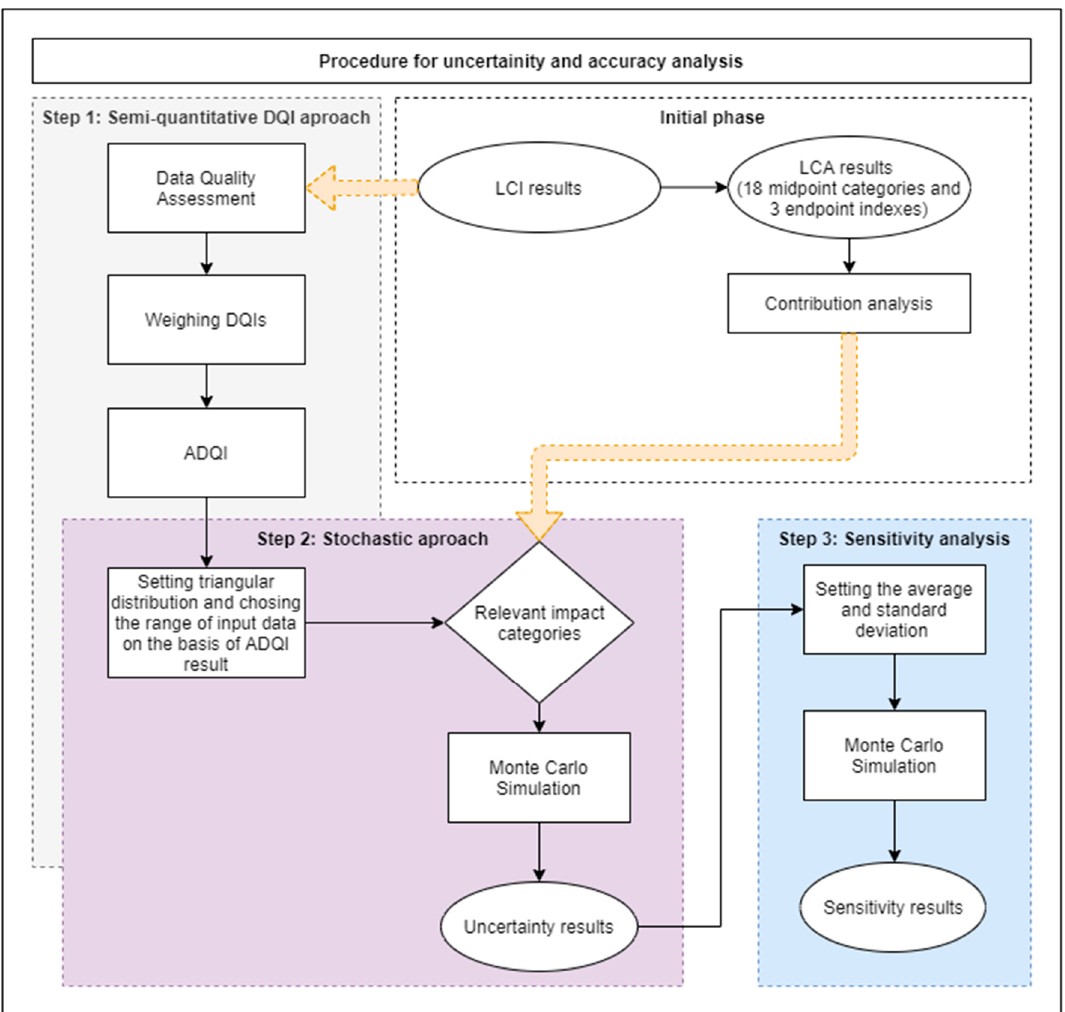
Figure 1. Flow chart of the uncertainty and accuracy management procedure.